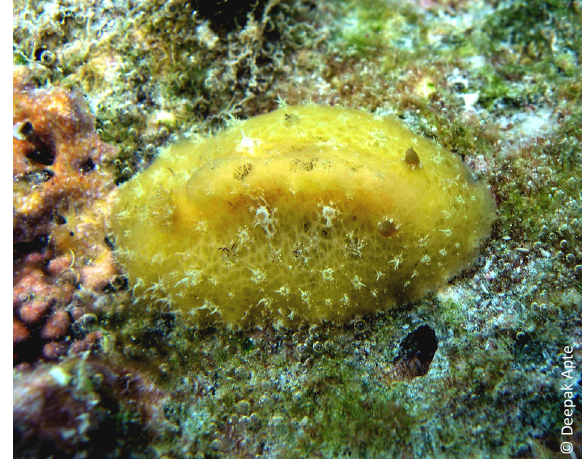
Image 7. Sclerodoris